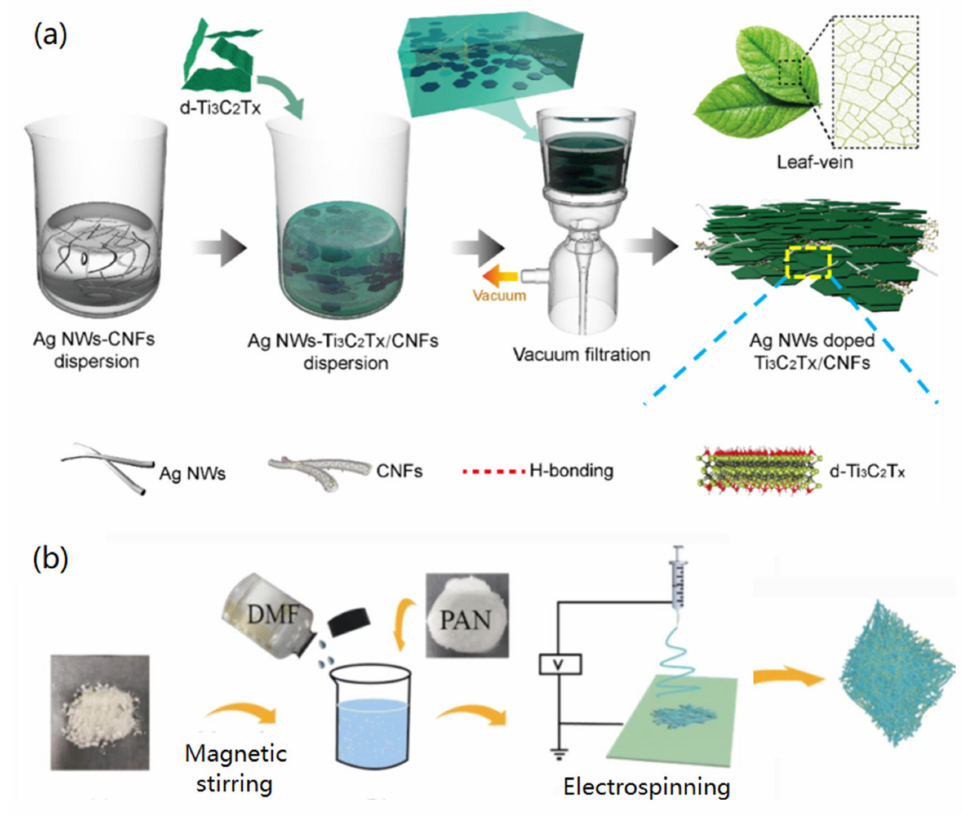
Figure 2. Fabrication of CNF-based 2D films/membranes via ( a ) vacuum filtration, reprinted with permission from Ref. [37], Copyright 2021, Elsevier Ltd., and ( b ) electrospinning, reproduced with permission from Ref. [38], Copyright 2020,